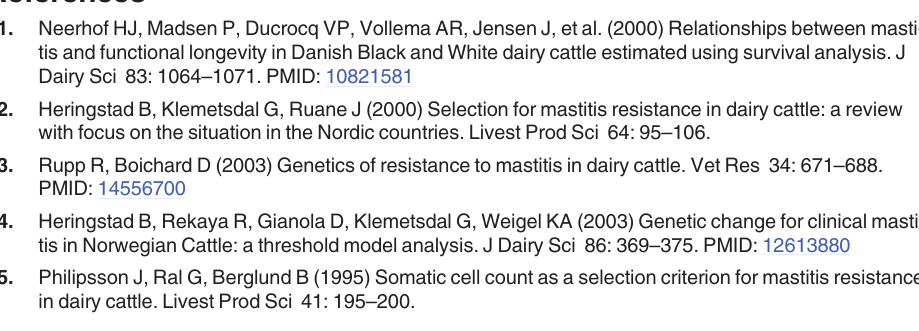
S1 Fig. Functional gene network ‘ Regulation of acute inflammatory response ’ highlighted within the general network. S2 Fig. Functional gene network ‘ Positive regulation of secretion ’ highlighted within the general network. S3 Fig. Functional gene network ‘ Regulation of protein activation cascade ’ highlighted within the general network. S4 Fig. Functional gene network ‘ Regulation of complement activation ’ highlighted within the general network. S5 Fig. Functional gene network ‘ Serine/threonine protein kinase complex ’ highlighted within the general network. S1 Table. List of SNPs located in the 10 windows that explained the greatest proportion of marker variance explained. The table reports position (in base pairs), rs (SNP ID from the National Center for Biotechnology Information), SNP name, and the proportion of overall genetic variance explained. S2 Table. List of genes involved in the co-expression network created using GeneMANIA with the respective number of connections for each gene. Names in bold were linked to clini- cal mastitis based on results of a literature